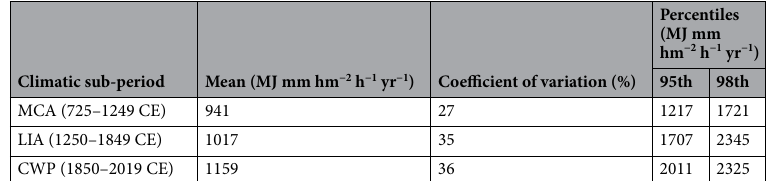
Table 1. Descriptive statistics for three climatic sub-periods of the modelled time-series of rainfall erosivity. MCA: Medieval Climate Anomaly; LIA: Little Ice Age; CWP: Current Warm Period.